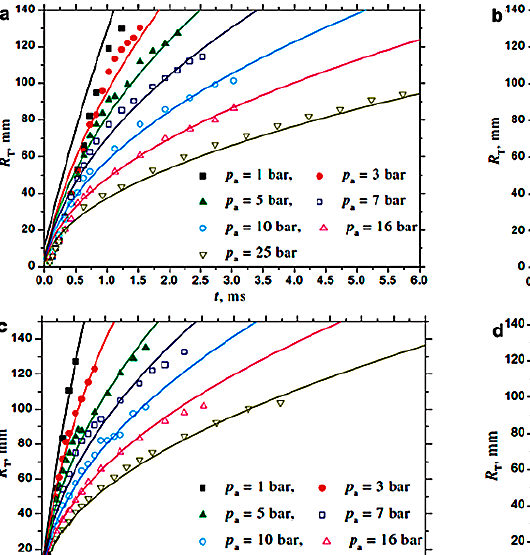
Table 4. Breakup time and breakup length of validation sprays.